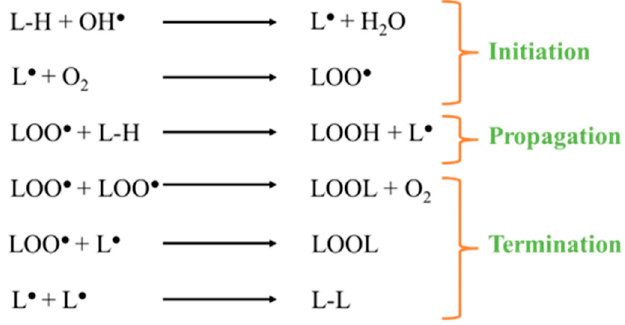
Figure 2. Process of lipid peroxidation .